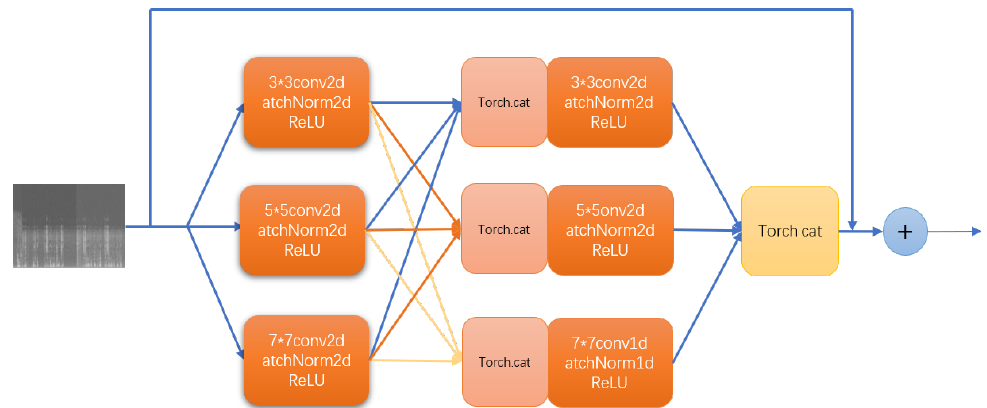
Figure 2. Multi-scale residuals